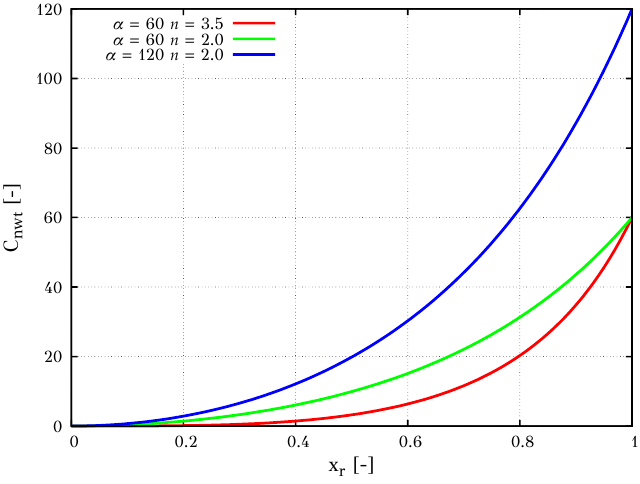
Figure 2. The effect of the values α and n in function C nwt